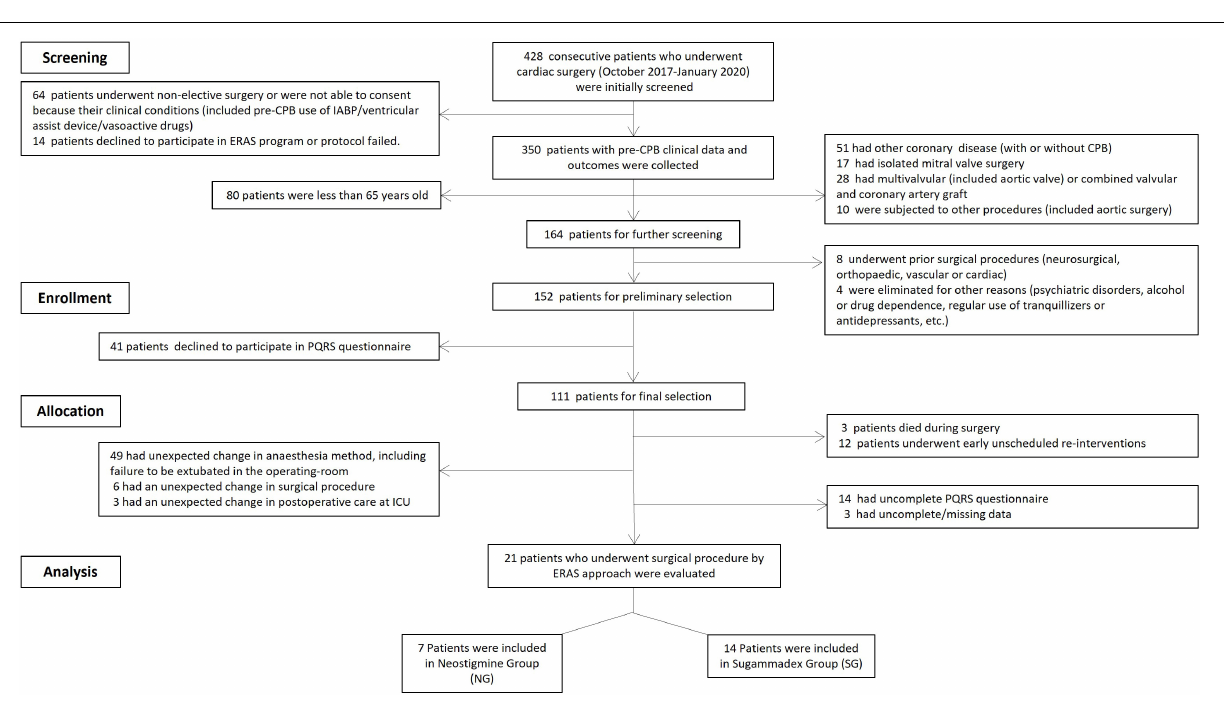
FIGURE 2 | Flow chart showing the patient selection process. Initially, a total of 428 cardiac surgery patients were recruited, but 407 did not meet the inclusion criteria; finally, 21 patients were included in the study, seven of whom (33.3%) were included in the neostigmine cohort group (NG), and 14 (66.7%) in the sugammadex cohort group